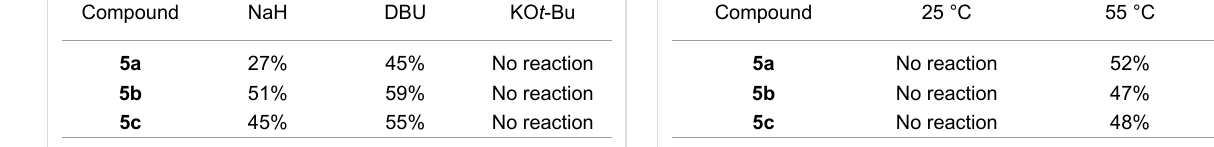
Table 1: Effect of different bases on the yield of compounds 5a , 5b and 5c a . Compound